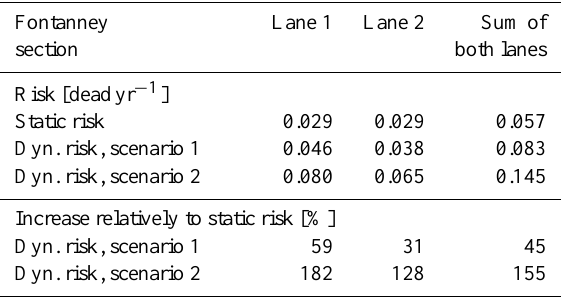
Fig. B1. Risk results on Fontanney section.